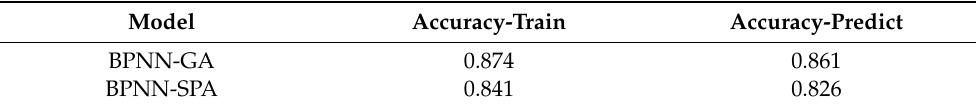
Figure 6. Confusion matrices of the training set ( a ) and the prediction set ( b ) for the BPNN model established by feature bands of GA. 3.3. Classification Based on Deep Learning The original spectra (Figure 7a) were transformed into 2D matrices (Figure 7b) ac ‐ cording to Formula (2) to exploit the synergistic relationship of different bands. As the relative relationship is more stable to environmental interference, for example, the slope between different spectral bands is not so sensitive to the shift of illumination intensity, and the 2D matrices can improve the robustness of the classification model in theory. Furthermore, the 2D matrices bring extra information besides the original reflectance values retained in the back diagonal according to the transform formula. To verify the effect of 2D transformation, all the matrices of the training set were employed to train the VGG net constructed according to the description in Section 2.4. From Table 3, it can be found that the modeling performance of the VGG net is much higher than that of the models based on feature engineering, and the classification accuracy of the prediction set achieved 0.961 for the VGG ‐ dilated model. This demonstrates that the CNN model es ‐ tablished based on 2D spectral transformation is effective at distinguishing the GM and